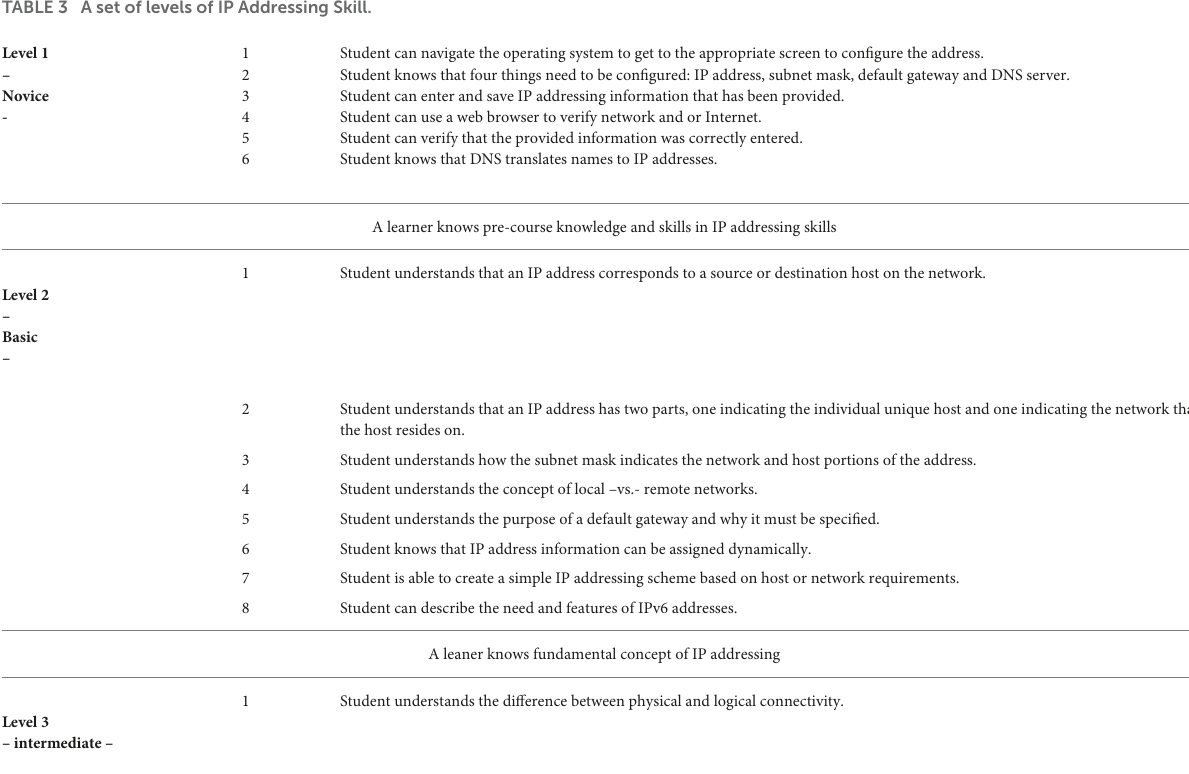
TABLE 3 A set of levels of IP Addressing